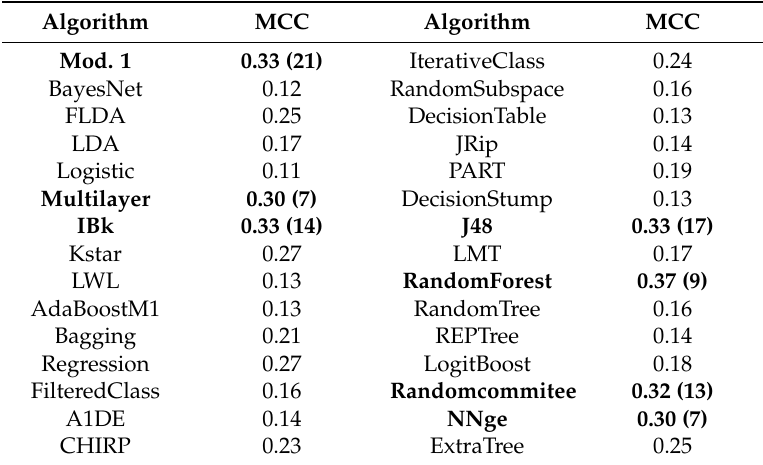
Table 3. Comparison of the predictive power (as encoded by MCC value) of Mod. 1 with the corresponding models obtained by using 29 different algorithms as implemented in Weka software. Algorithm MCC